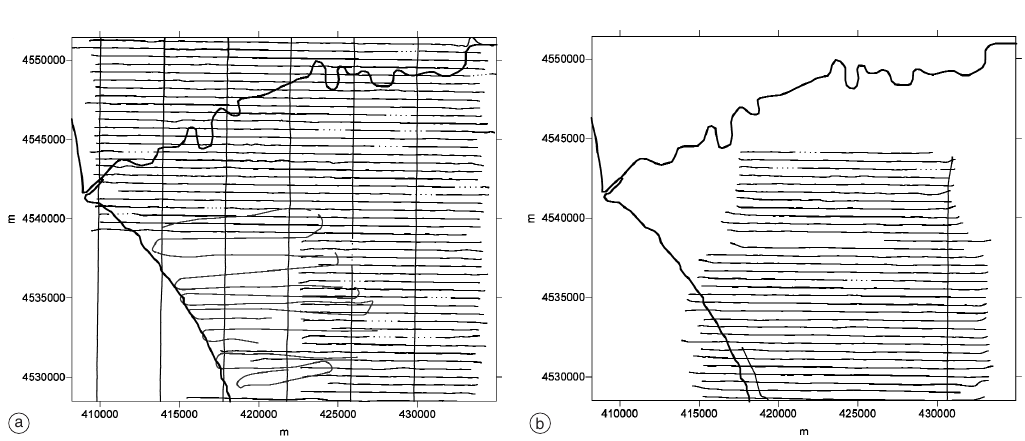
Fig. 2a,b. Flight lines flown in the new survey. a) Flight lines relative to the first level (70 m above the ground surface); the lines in grey are relative to the preliminary survey carried out in 1999, while the black fly lines are relative to the survey of 2001. b) Flight lines relative to the second level (400 m above the ground